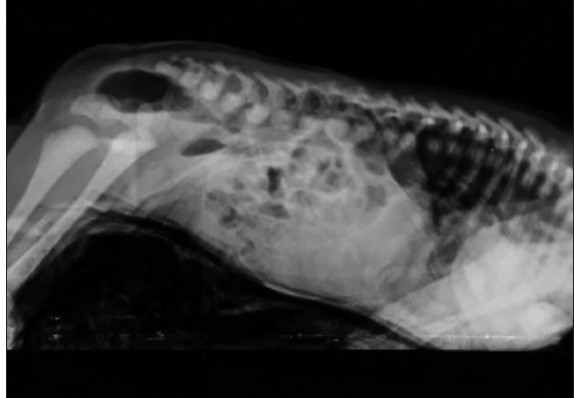
Figure 2: Prone cross table lateral X-ray showing gas shadow between PC line and I line indicating intermediate anorectal